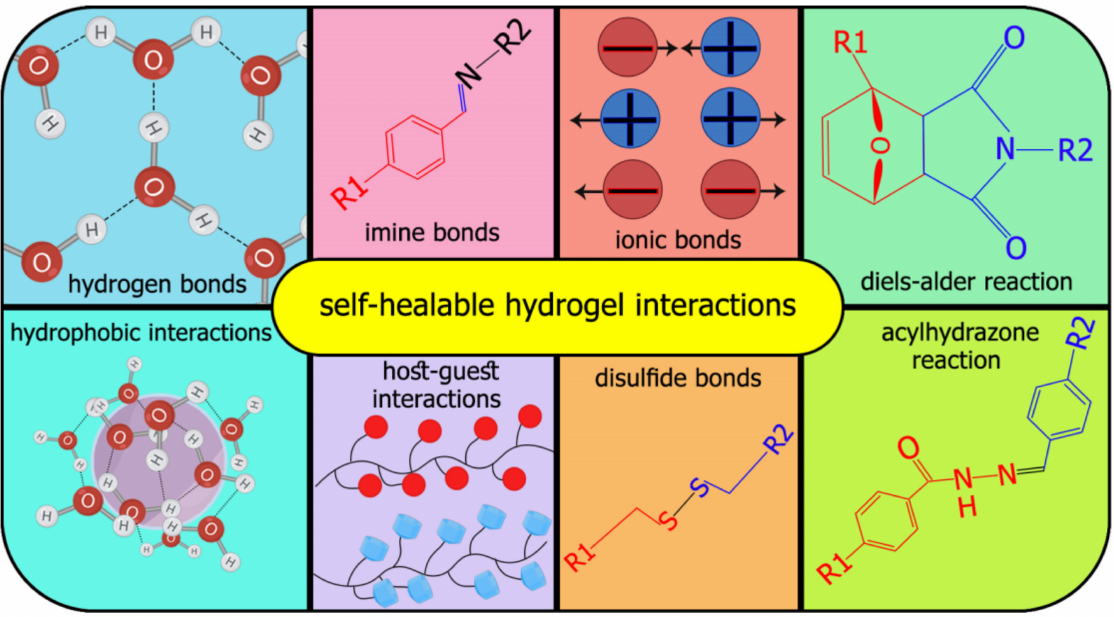
Figure 1. The numerous chemical and physical interactions behind self-healable